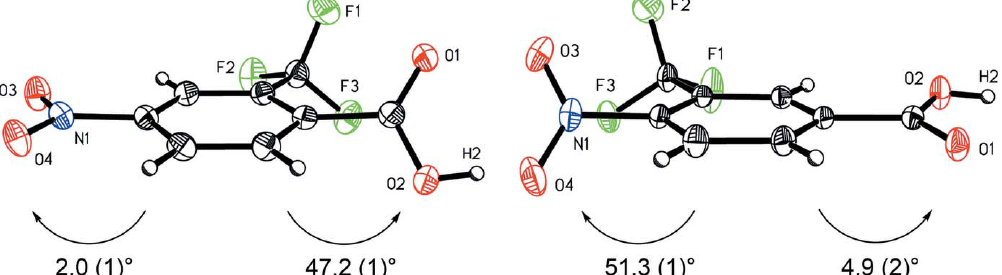
Figure 3 Side-by-side views of 4-nitro-2-(trifluoromethyl)benzoic acid (I) (left) and 4-nitro-3-(trifluoromethyl)benzoic acid (II) indicating the rotation of the carboxyl and nitro groups out of the mean plane of the aromatic ring.